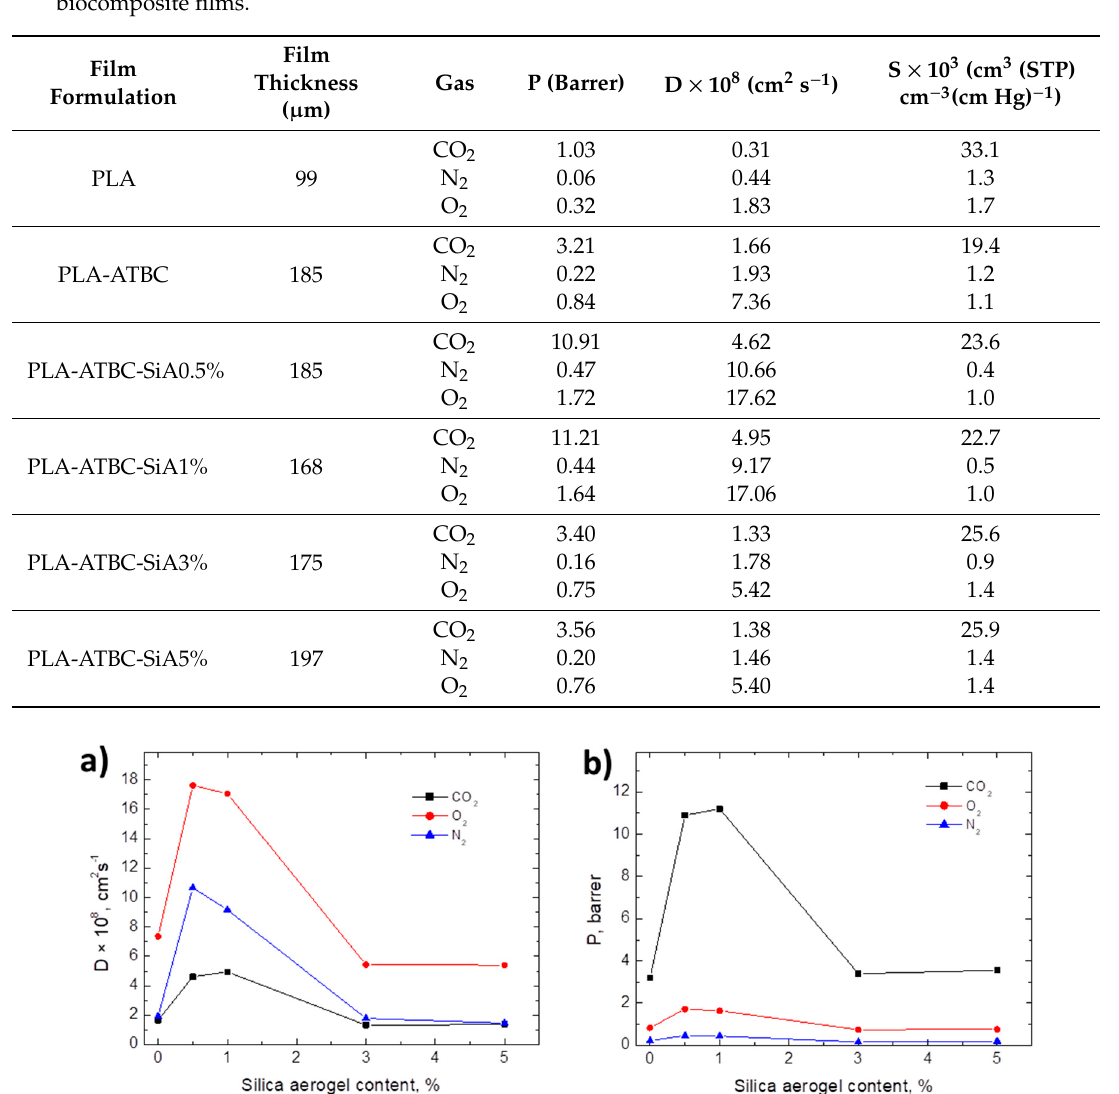
Figure 4. ( a ) Di ff usivity and ( b ) permeability as a function of the aerogel Figure 4. ( a ) Diffusivity and ( b ) permeability as a function of the aerogel content.